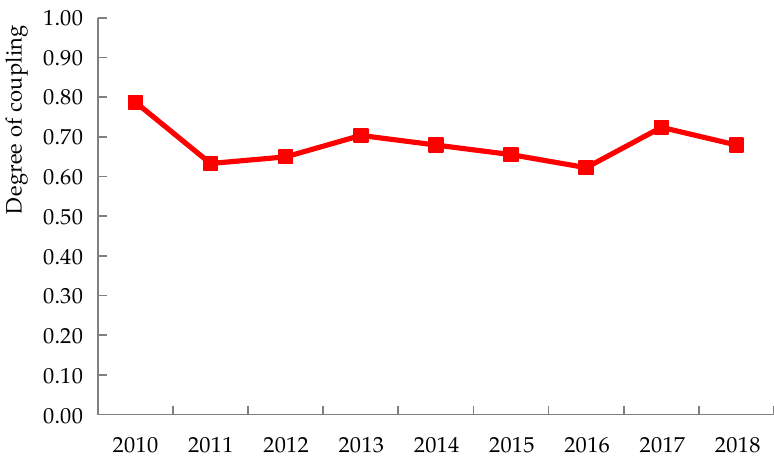
Figure 8. Coupling degree of RT and CLT in Linqing County from 2010 to 2018.